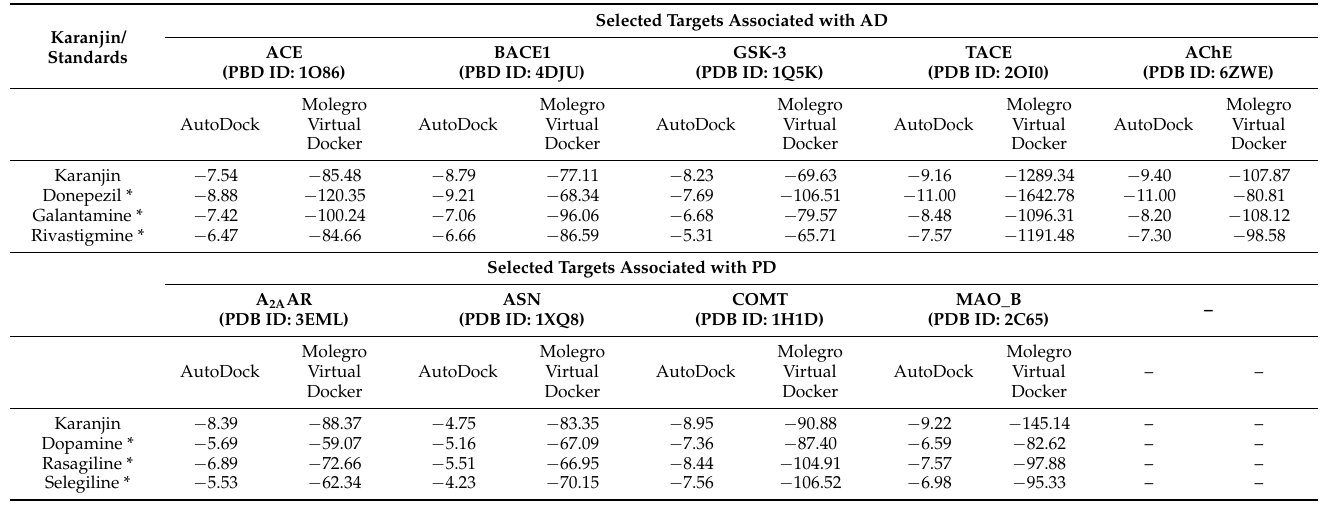
Table 2. Molecular docking score (kcal/mol) of karanjin with three standard drugs against four different human targets proteins associated with AD and PD.